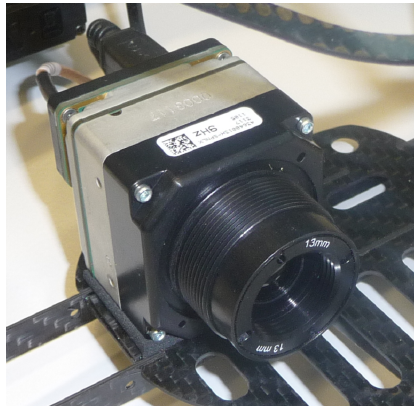
Figure 4: Thermal camera FLIR Tau 640; focal length